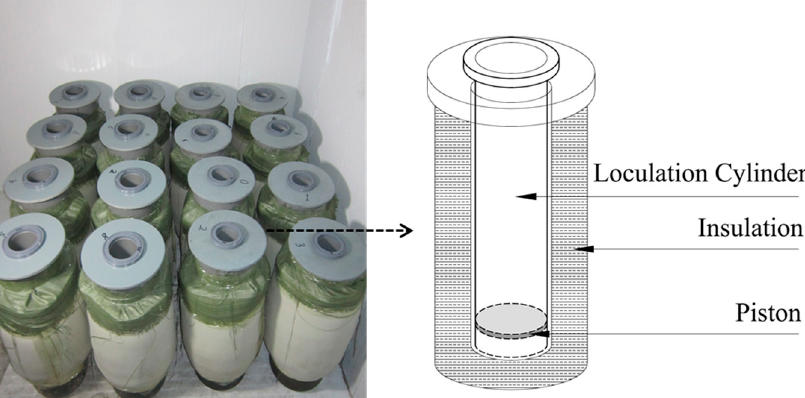
Figure 1. Device for unidirectionally simulating the freezing of lake water.